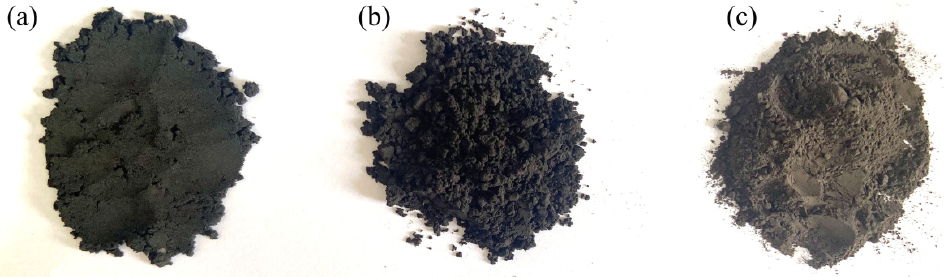
Figure 6. The appearance of flotation feedstock and products. ( a ) FEBFS samples, ( b ) OPFC sam- ples, and ( c ) OPFT samples. and ( c ) OPFT